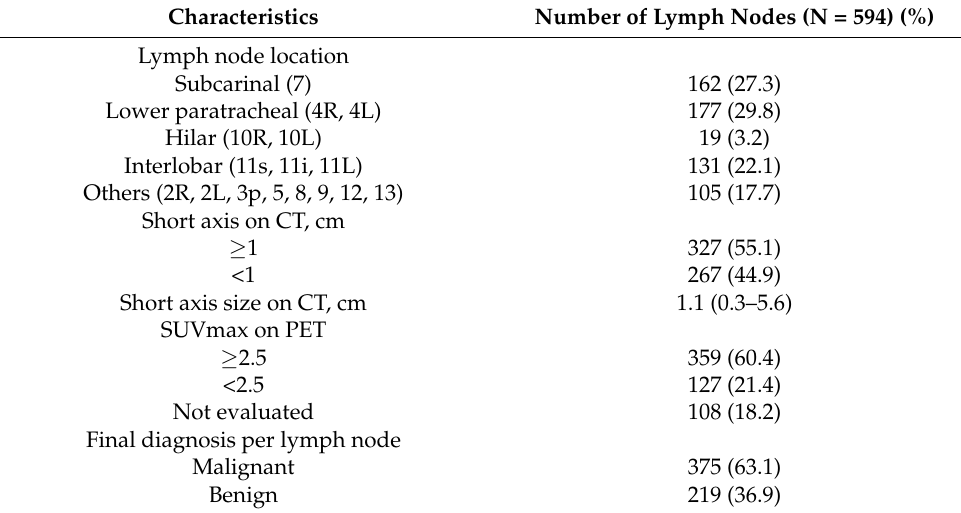
Table 2. Baseline characteristics of lymph